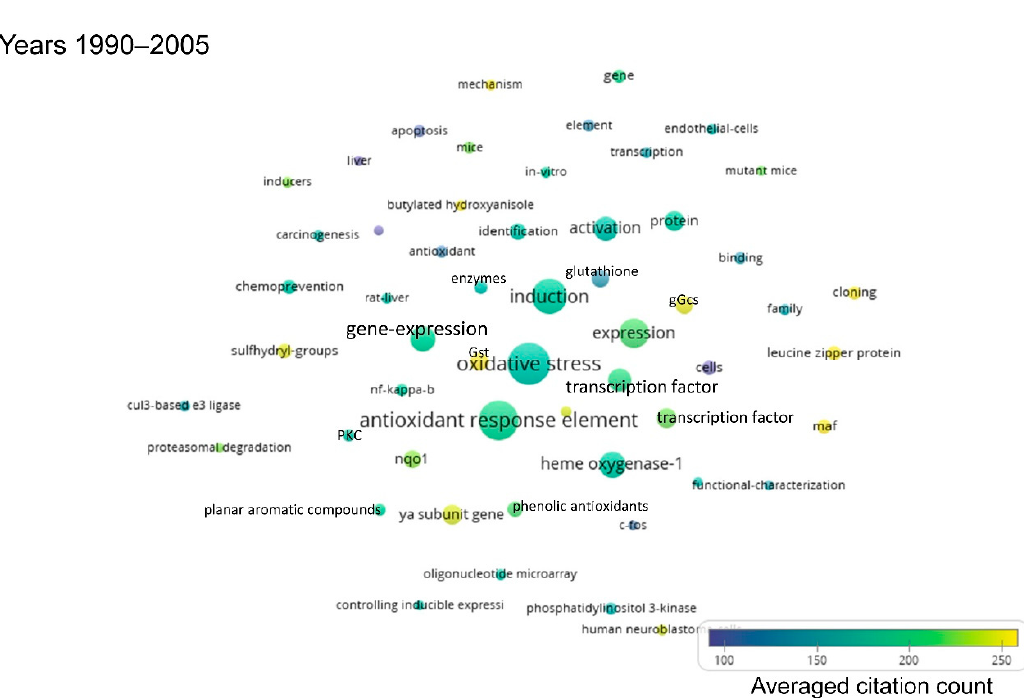
Figure 1. ( A ) Number of publications about Nrf2 per year. The numbers on top of the first bars indicate the exact number of publications for the respective year. Data up to July 2019. ( B ) Cumulative number of publications about Nrf2 per year. Data up to July 2019.